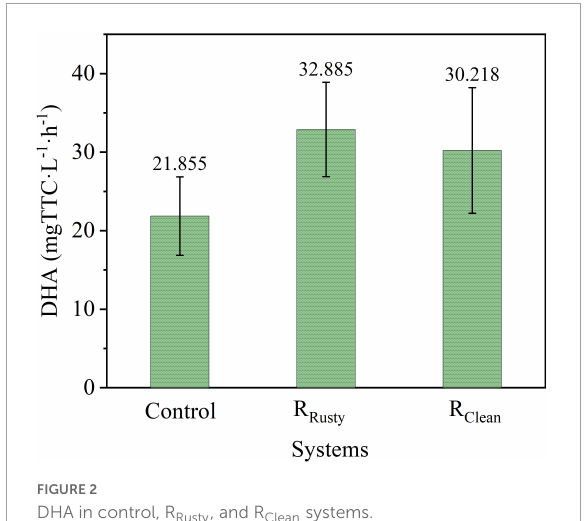
FIGURE2 DHA in control, R Rusty , and R Clean